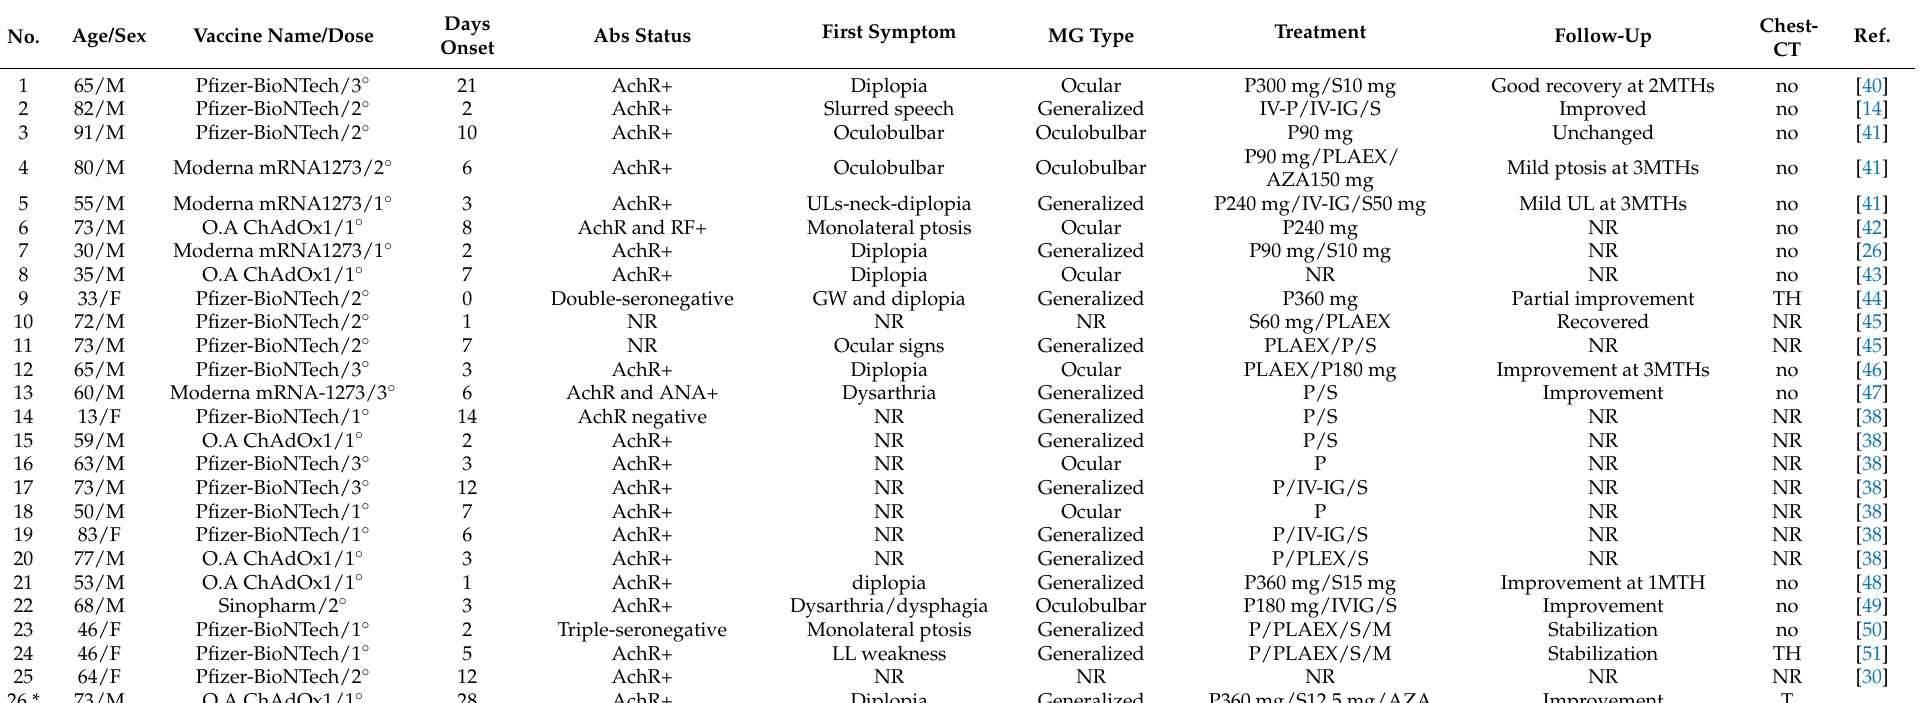
Table 1. Characteristics of the new-onset cases with myasthenia gravis (MG) cases in timely association with SARS-CoV-2